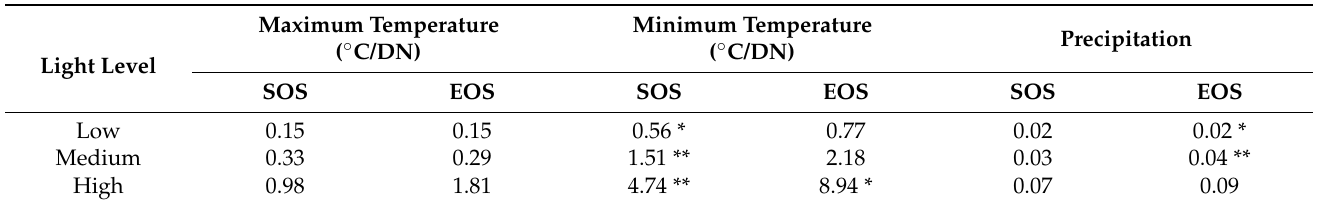
Table 1. Sensitivity of preseason climate factors to urbanization at different nighttime lighting